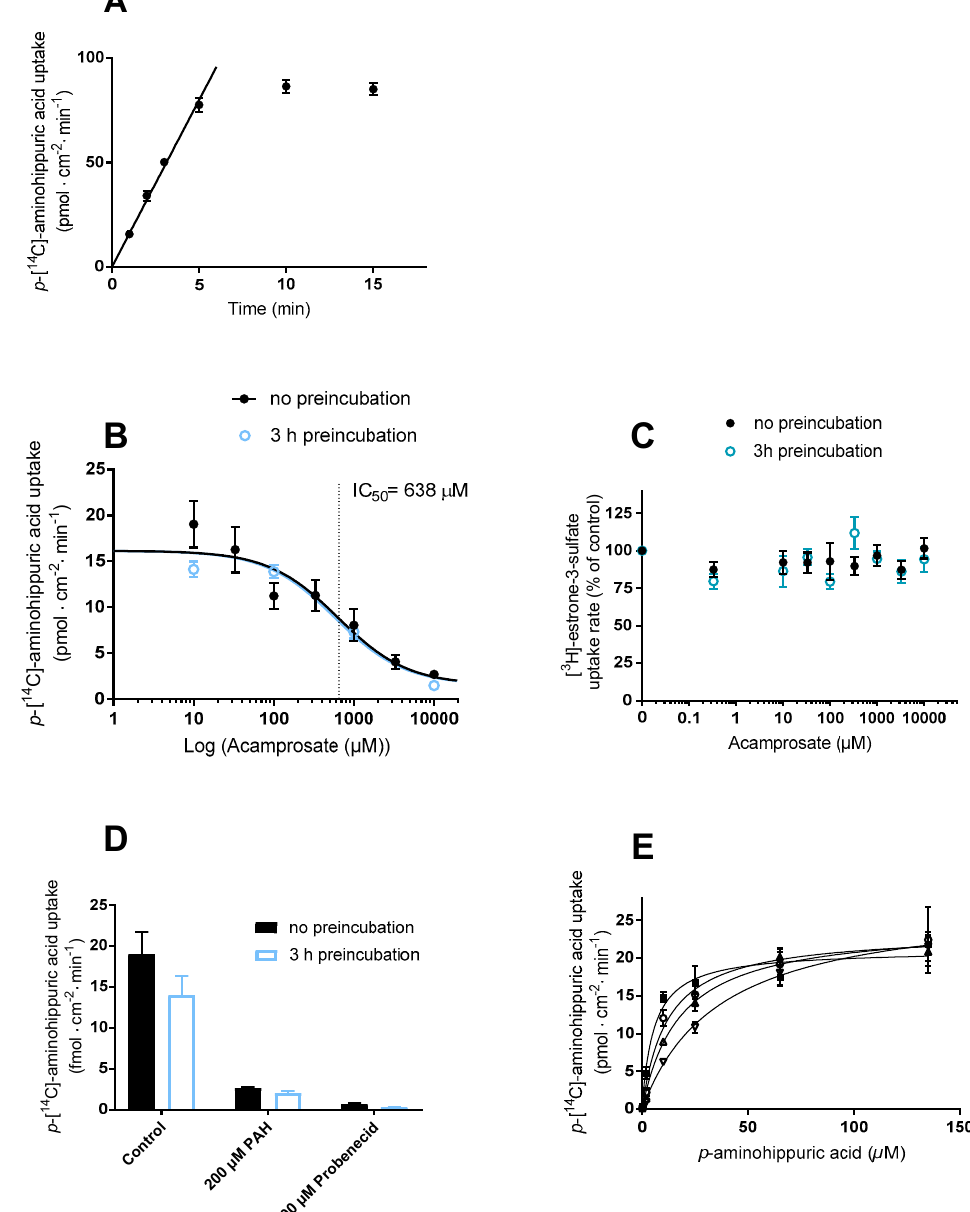
Figure 5. ( A ) Time-dependent uptake of 9.5 µ M [ 14 C]-PAH in HEK293-Flp-In OAT1 expressing cells. ( B ) E ff ect of 0–10,000 µ M acamprosate on the uptake rate of 9.5 µ M [ 14 C]-PAH in HEK293-Flp-In cells with either applied concomitantly (black filled circles) or after 3 h preincubation with the same acamprosate concentration dissolved in cell medium (blue empty circles). ( C ) Uptake of 0.02 µ M (1 µ Ci / mL) [ 3 H]-estrone-3-sulfate (E3S) in HEK293-Flp-In OAT3 expressing cells with either applied concomitantly (black filled circles) or after 3 h preincubation with the same acamprosate concentration dissolved in HBSS bu ff ered with 10 mM HEPES and the pH was adjusted to 7.40 ± 0.01 (blue empty circles). ( D ) Uptake of 9.5 µ M [ 14 C]-PAH in OAT1 expressing cells in the presence of 200 µ M p -aminohippuric acid or 300 µ M probenecid either applied concomitantly (black filled circles) or after 3 h preincubation with the indicated concentration dissolved in cell medium (open blue bars). ( E ) Concentration-dependent uptake of PAH in OAT1 HEK293-Flp-In cells in the presence of 0 µ M (black filled squares), 625 µ M (open squares), 1250 µ M (open triangles), or 2500 µ M acamprosate (open triangles). ( A – E ) The pH of the applied bu ff ers was 7.4. Each data point represents mean ± SEM of replicates in three cell passages obtained in Lab.